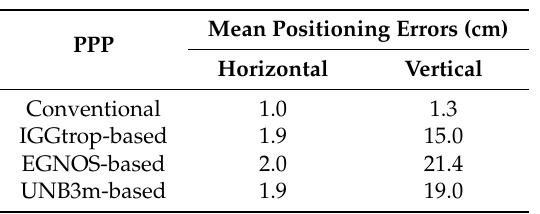
Figure 8. Time series of positioning errors for the conventional, IGGtrop-based, EGNOS-based and UNB3m-based PPP solutions at stations of BJFS, ZHNZ, XIAG and LHAZ, the DOY represents the day of year in 2012. As can be seen from Figure 8, the positioning errors of the conventional PPP (green) in east, north and up components vary little and are of small values throughout the whole year of 2012 (except for a few outliers). However, for the IGGtrop-based (blue), EGNOS-based (red) and UNB3m- based (green) PPP, the positioning errors in north components are relatively stable, but in east components, the errors show slightly seasonal variations with the amplitudes of a few (2–6) centimeters, and the characteristics of variations depend on each specific station, and the reasons deserved to be further studied. Furthermore the errors in east components are usually larger than those in north components which are consistent with the results of Chen et al. [24] although the kinematic rather than static PPP mode they used. The vertical positioning errors of the IGGtrop-